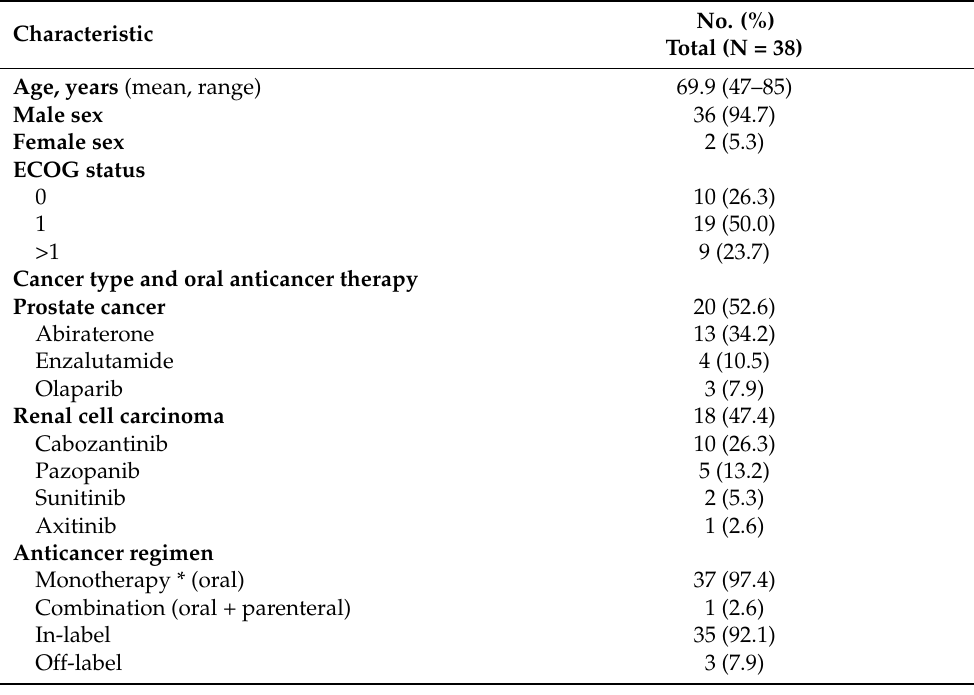
Table 1. Baseline clinical characteristics of the patients with PC or